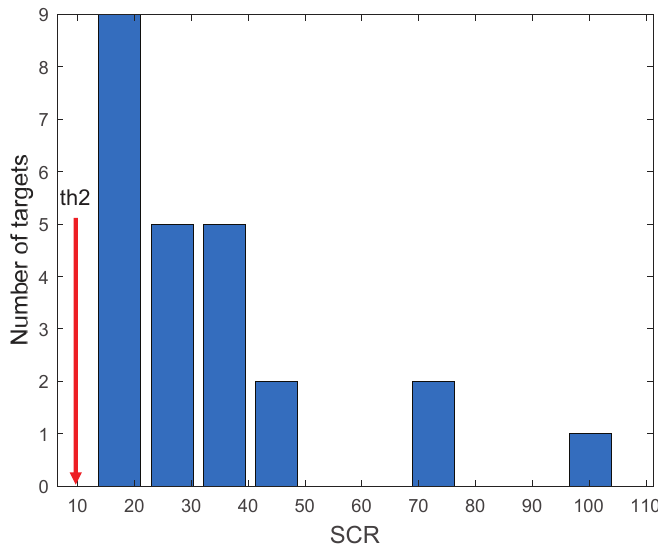
Figure 12. Parameter analysis of threshold 1 ( th 1) from directional mean subtraction image.